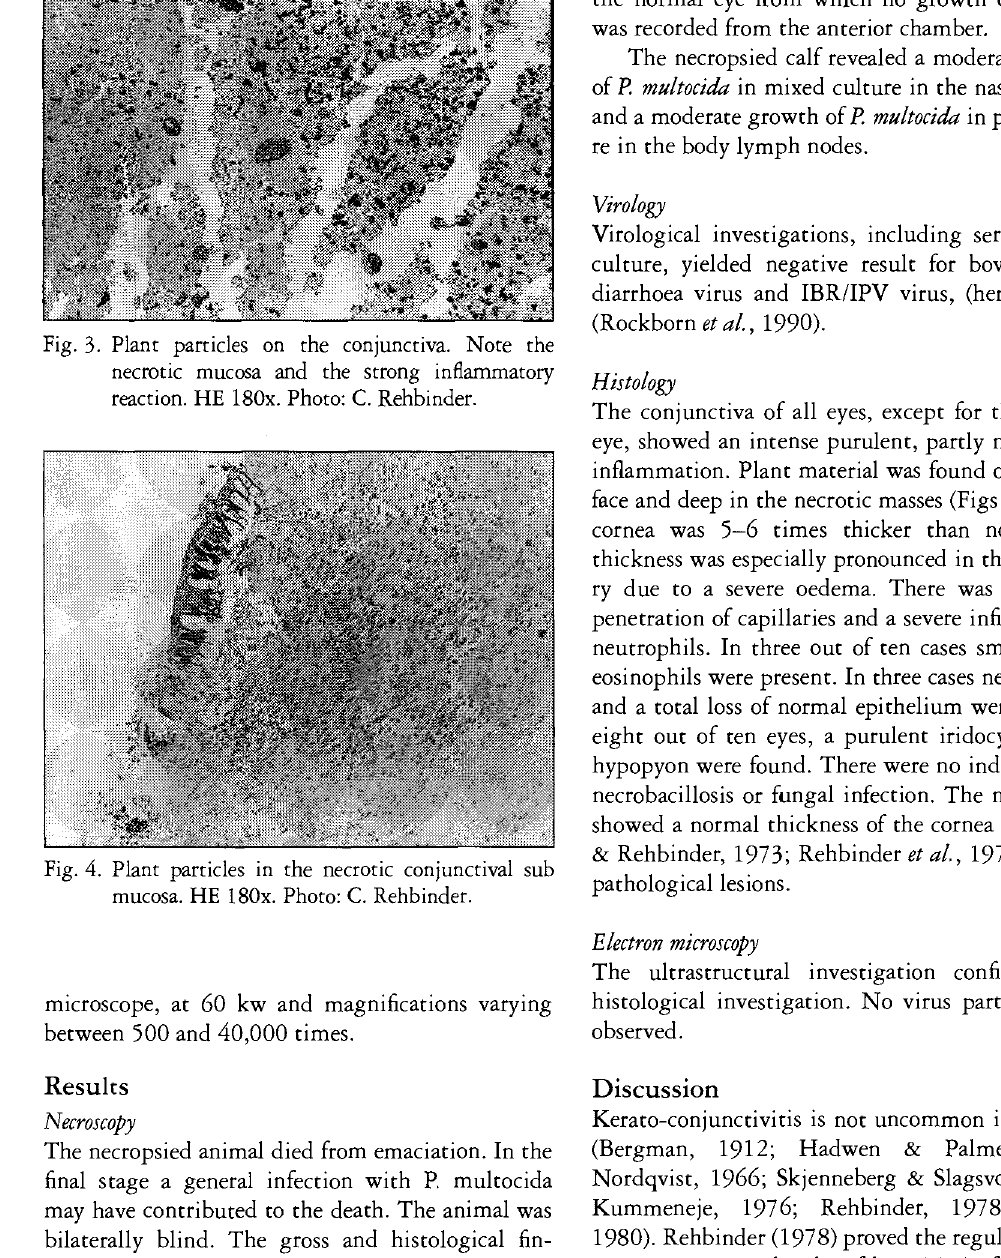
microscope, at 60 kw and magnifications varying between 500 and 40,000